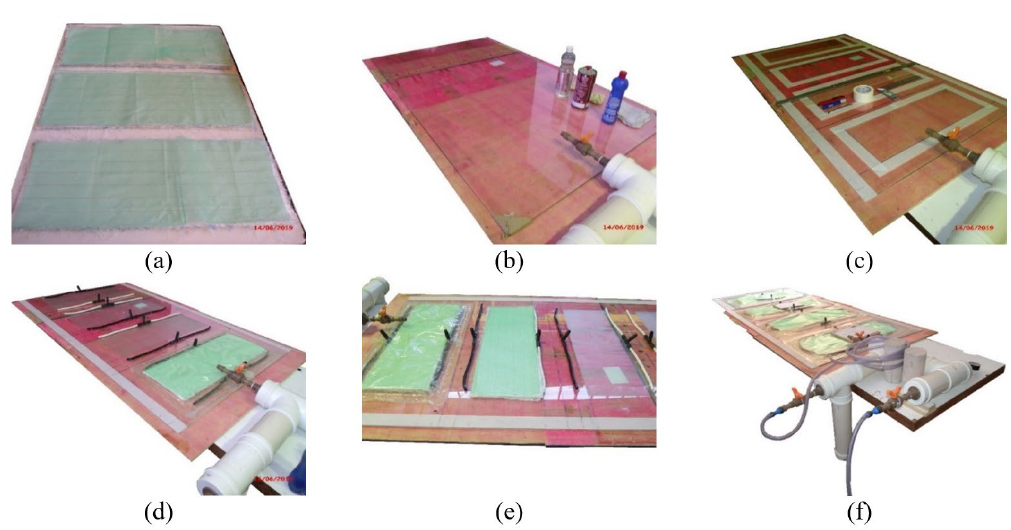
Figure 2. GFRP composite fabrication process: (a) curing and preparation of the materials; (b) cleaning of the glass plate; (c) location of the infusion area and application of carnauba wax; (d) positioning of the pipes, spiral tubes and materials over the glass plate; (e) lateral view of the positioning of the pipes, spiral tubes and materials over the glass plate; (f) resin infusion system ready for use, requiring only the positioning of the last